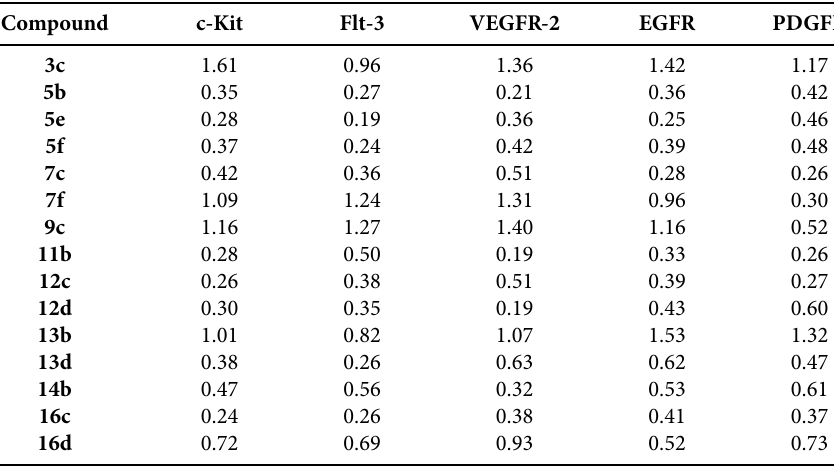
Table 2. Inhibition of tyrosine kinases (Enzyme IC 50 (nM) by compounds 3c , 5b , 7c , 7f , 9c , 11b , 12c , 12d , 13b , 13d , 14b , 16c and 16d Compound